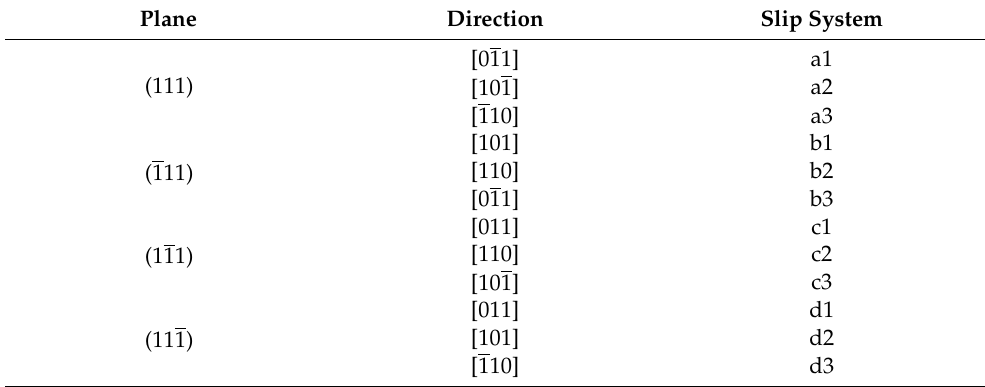
Table 2. Slip systems of face-centered cubic (FCC) pure aluminum.